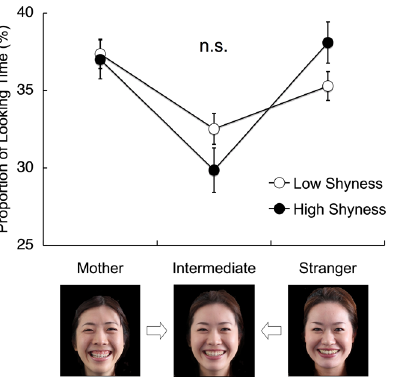
Figure 2. Infants’ visual preferences for different face types. This figure shows the mean percentile fixation durations for the following three face stimuli: mother, intermediate and stranger. The bottom pictures present examples of the face stimuli. The open and filled circles represent the mean fixation durations for the infants with low and high shyness, respectively. Error bars indicate the S.E. of the mean. n.s.: no significant difference.